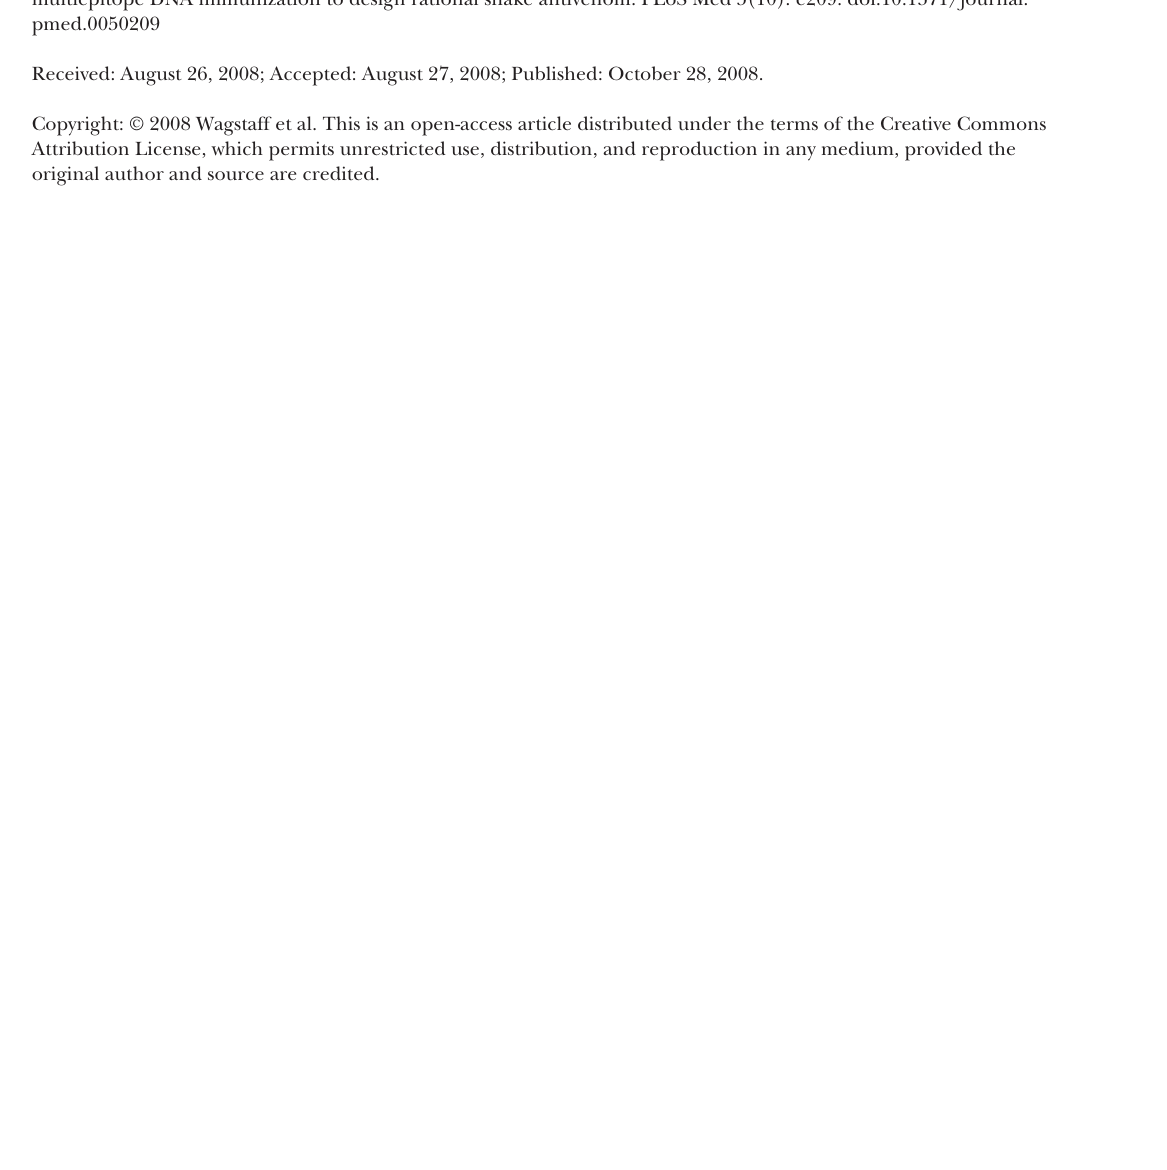
Figure S1. Comparative Sequence Analysis of Full-Length PI-PIII SVMP Isoforms Found at doi:10.1371/journal.pmed.0050209.sg001 (48 KB PDF). Figure S2. Composition of the E. ocellatus Venom Gland Transcriptome Found at doi:10.1371/journal.pmed.0050209.sg002 (32 KB